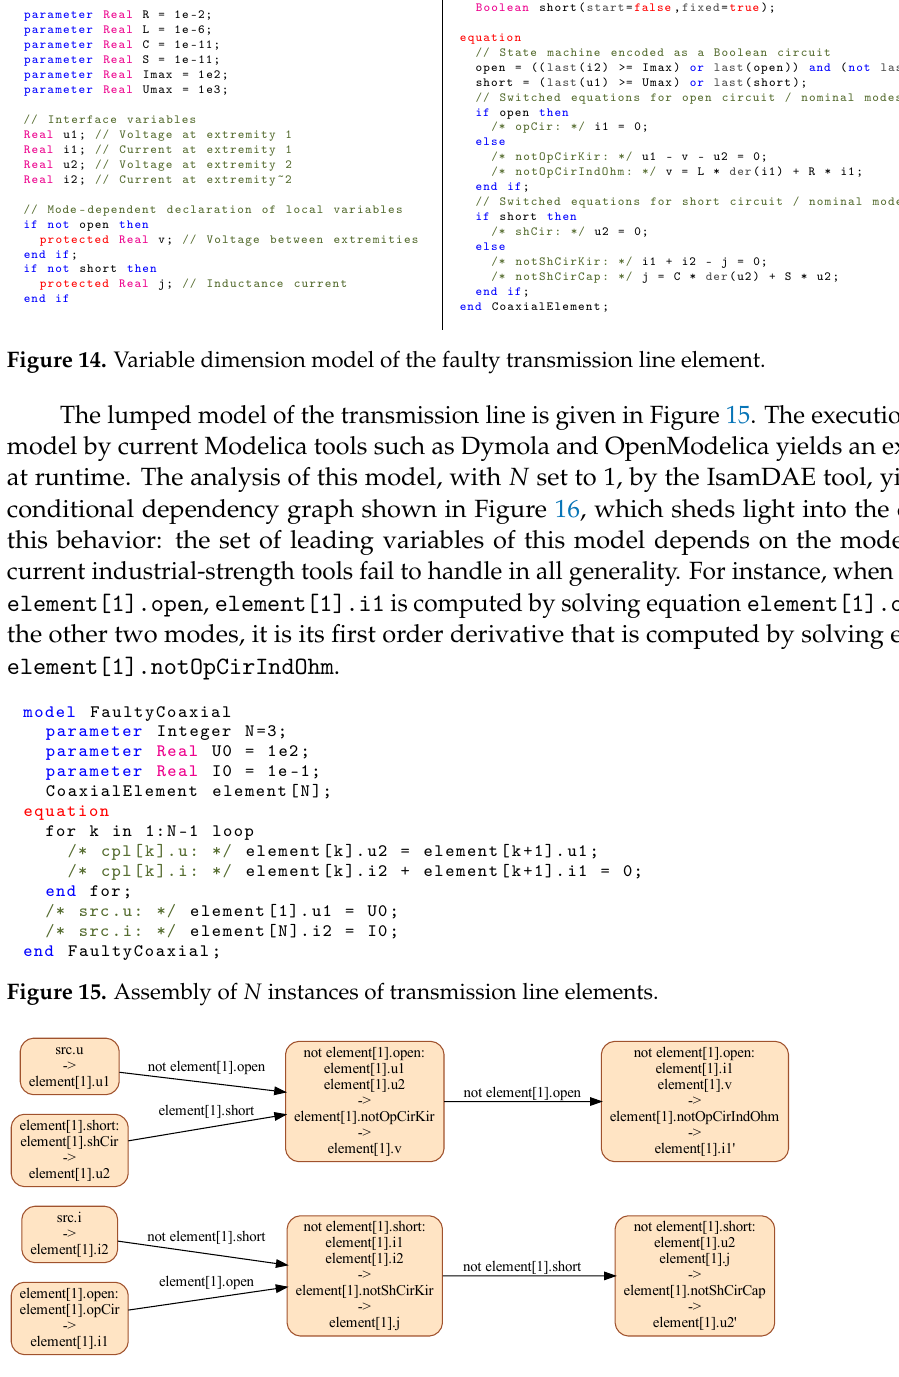
Figure 16. CDG resulting from the multimode structural analysis of the FaultyCoaxial model with N = 1. This graph shows, in particular, that it is a variable structure system, where the set of leading variables depend on the